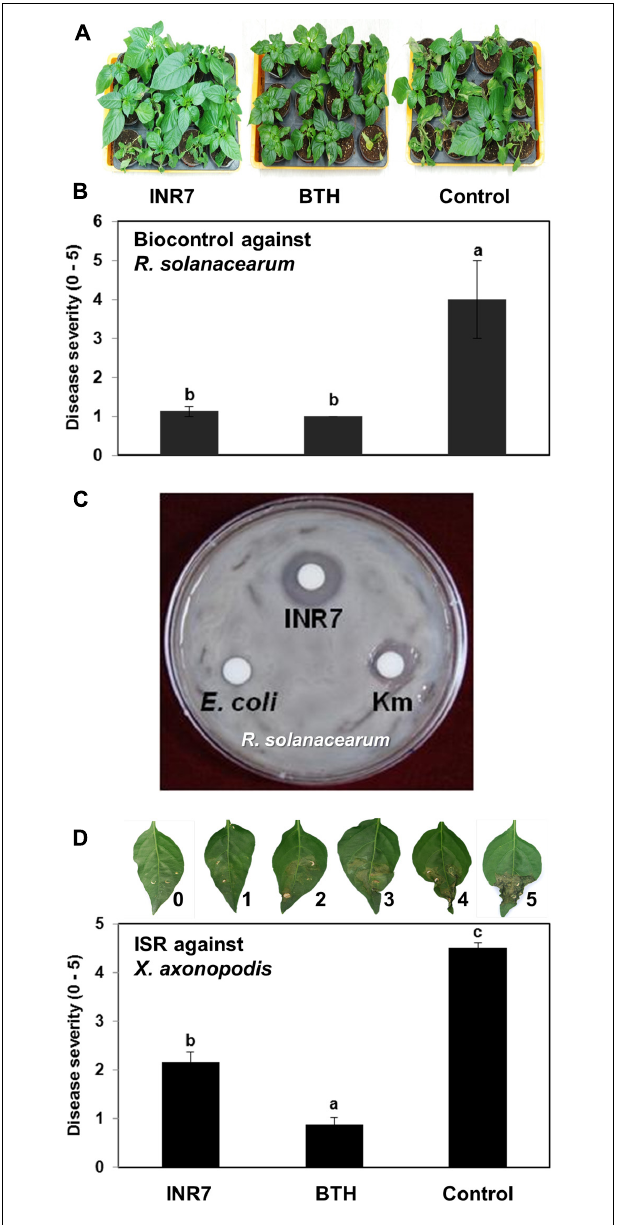
FIGURE 1 | Disease suppression capacity of Bacillus pumulus INR7 against Xanthomoans axonopodis pv. vesicatoria and Ralstonia solanacearum in the greenhouse (A) Presentative photo for biocontrol of bacterial wilt caused by Ralstonia solanacearum . The photo was taken at 3 weeks after pathogen challenge into root. (B) Biocontrol against Ralstonia solanacearum by B. pumulus INR7.The disease severity was measured 3 weeks after pathgoen challenge in the soil. Bars represent mean ± SE, sample size N = 27 plants per treatment. (C) Direct inhibition of Ralstonia solanacearum growth on the PGC medium.The photo was taken 2 days after bacteria and kanamycin inoculation on the paper disk. (D) Induction of plant resistance against a compatible X. axonopodis pv. vesicatoria. Disease severity was measured 7 days after X. axonopodis pv. vesicatoria challenge. Bars represent mean ± SEM, sample size N = 10 plants per treatment. 0.5 mM BTH was used as positive control. Different letters indicate significant differences between treatments ( P = 0.05), according to the least significant difference (LSD).The experiments was repeated three times with similar